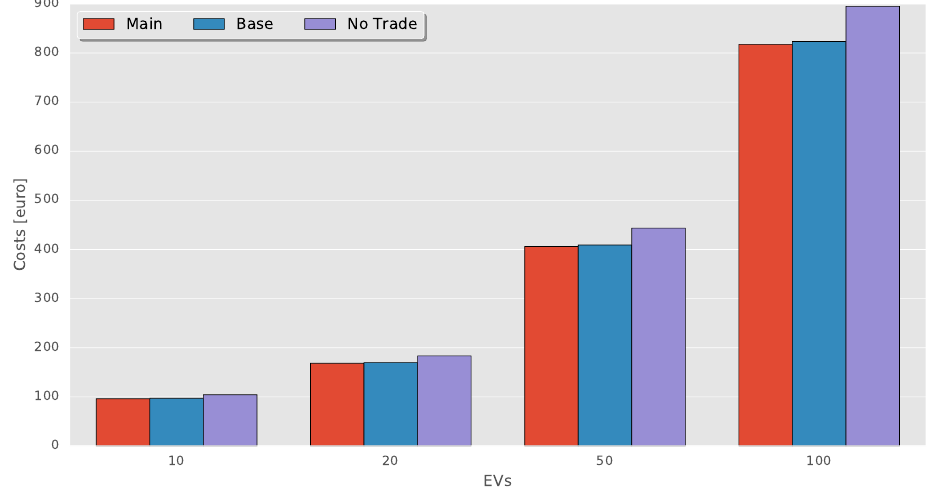
Figure 3. Costs arising from charging different numbers of EVs per day averaged over 35 days. The costs are shown for the three considered scenarios. A lead time of 30 min (2 intervals) and a trading unit of 100kW is assumed for the intraday market